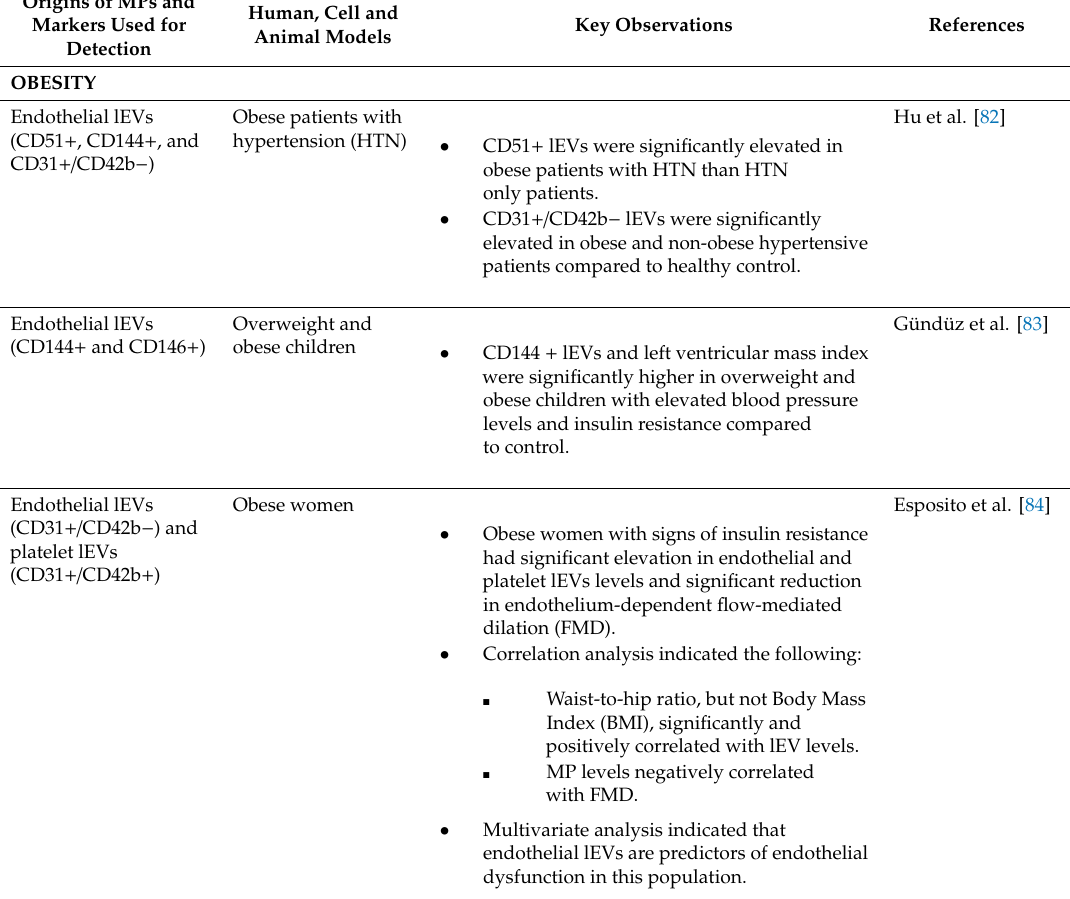
Table 2. Summary of the main studies of altered lEV (MP) levels and their associated e ff ects on obesity in human, in vitro and animal